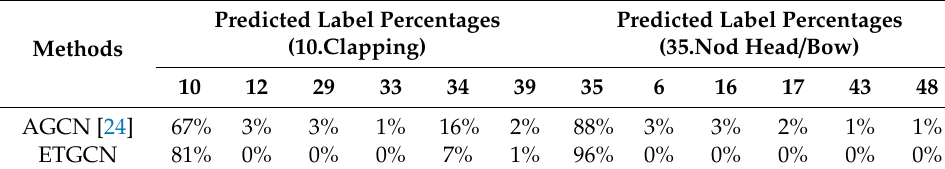
Table 4. Confusion matrix for the action of “10.clapping” and “35.nod head / bow”.